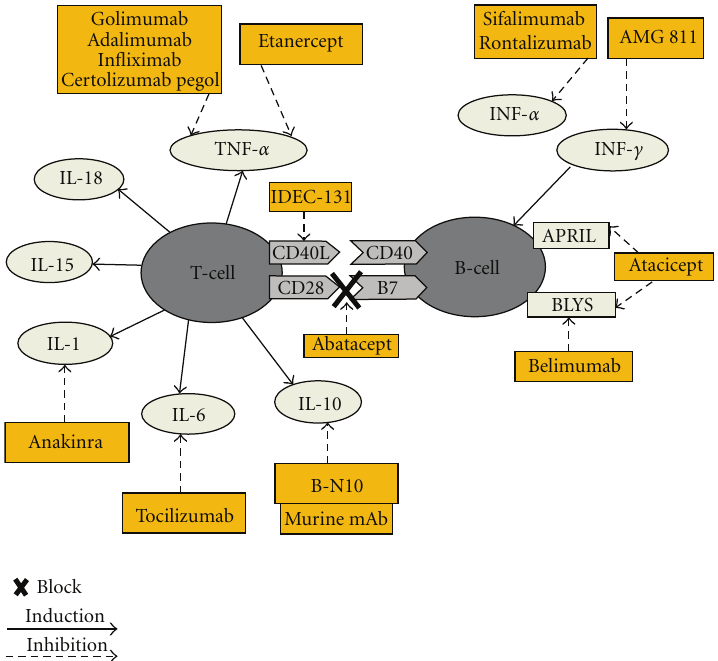
Figure 1: Potential targets and relevant drugs in connection with B and T cells in the management of